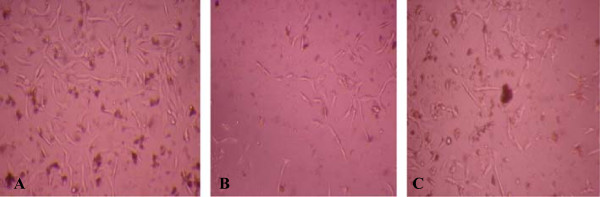
The cells of Balb/C untreated and treated with xylem sap and fisetin. A- The cell-fibroblast Balb/c 3T3-A31 untreated. B- Cells treated with fresh xylem sap of H. courbaril at a concentration of 64 μg/mL. C- Cells treated with fisetin 1 at a concentration of 128 μg/mL. Photomicrograph at 200X by inverted microscope.